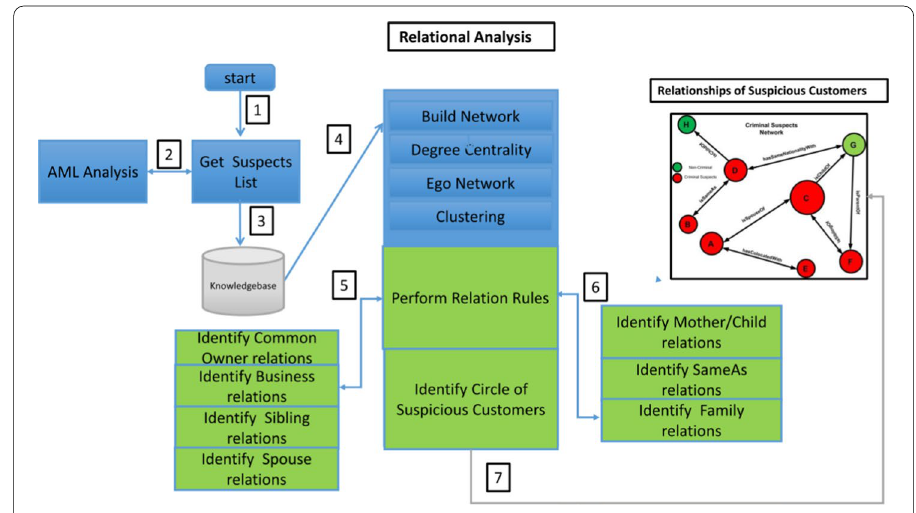
Fig. 3 Flow chart of relational